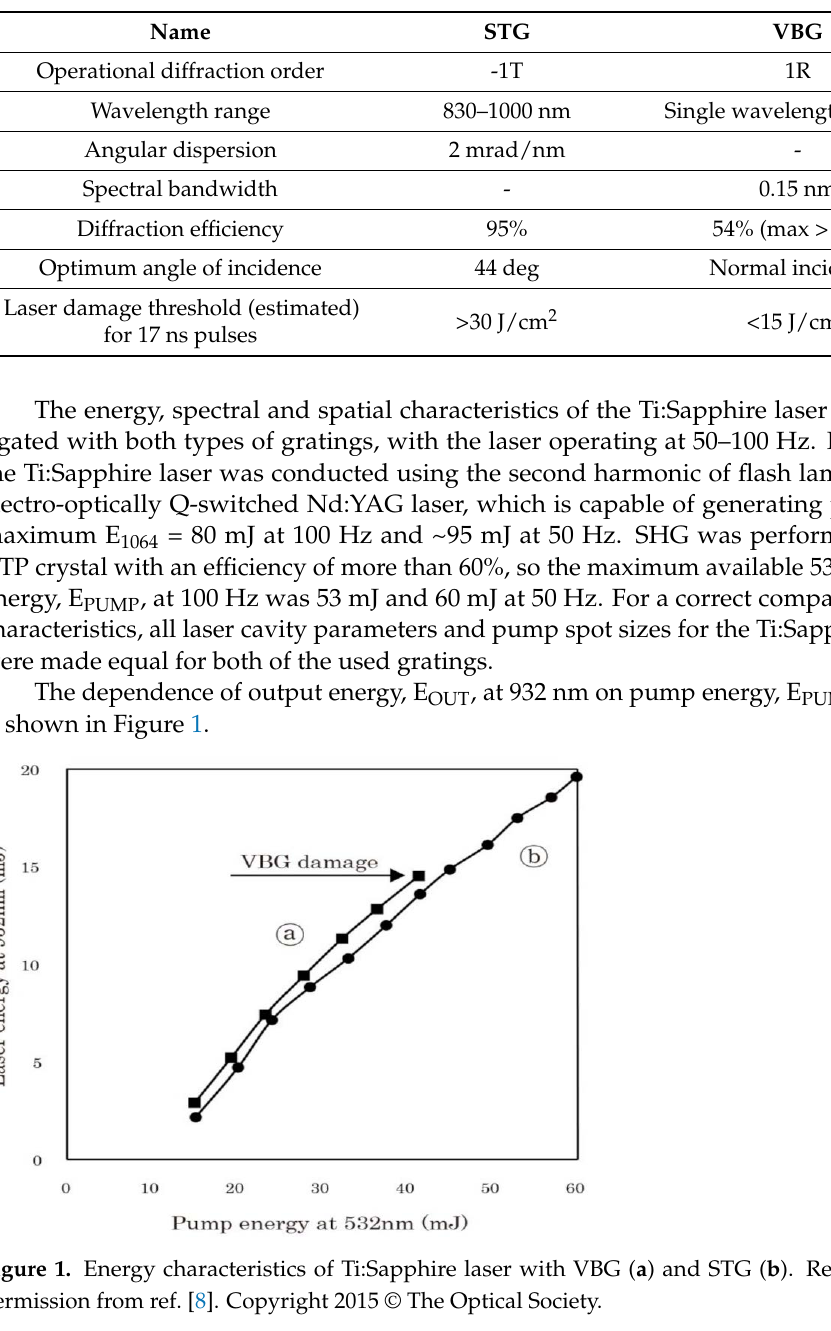
Table 1. Parameters of diffraction gratings.